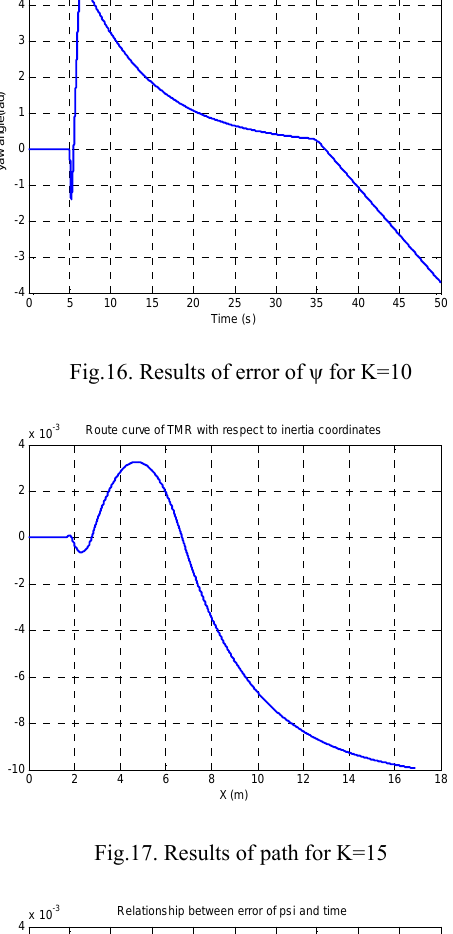
Fig.17. Results of path for K=15